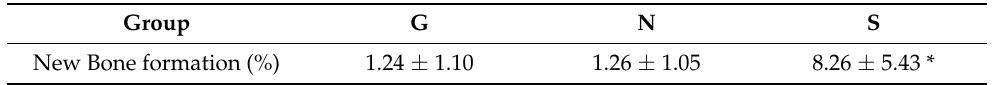
Table 2. New bone formation in histological analysis.